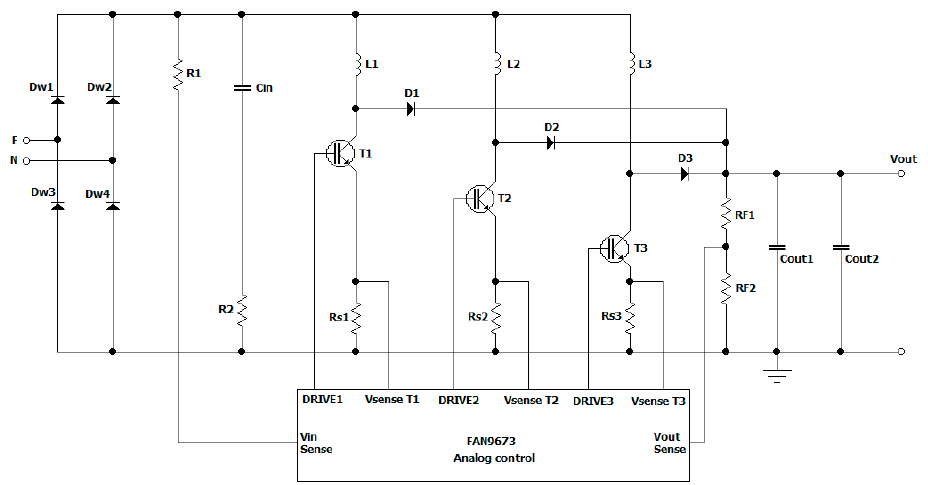
Figure 6. The Power Supply Unit (PSU).